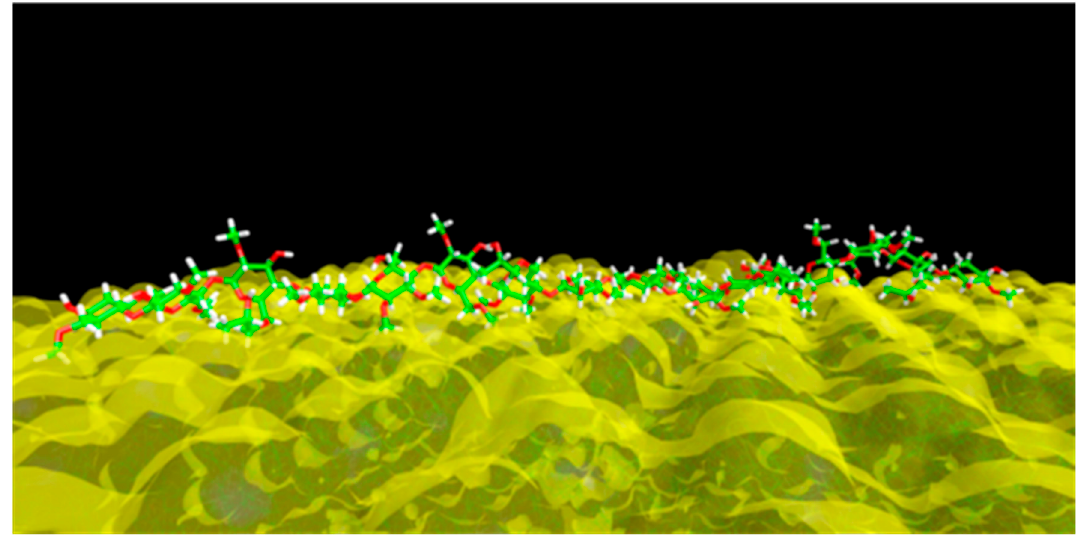
Figure 12. Adsorbed HPMC molecule on the (100) face mapped with an isosurface colored according to the molecular electrostatic potential (MEP).